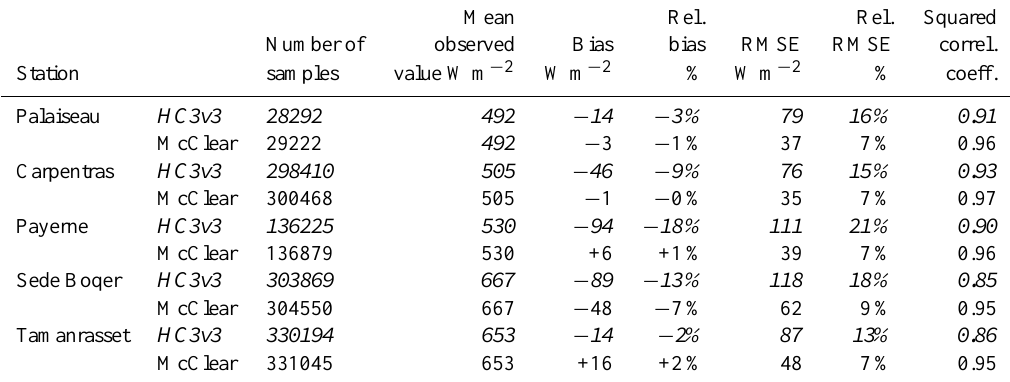
Table 7. Comparison between clear-sky beam irradiances on a horizontal surface measured by BSRN and estimated by HelioClim-3v3 (HC3v3, in italics) or by